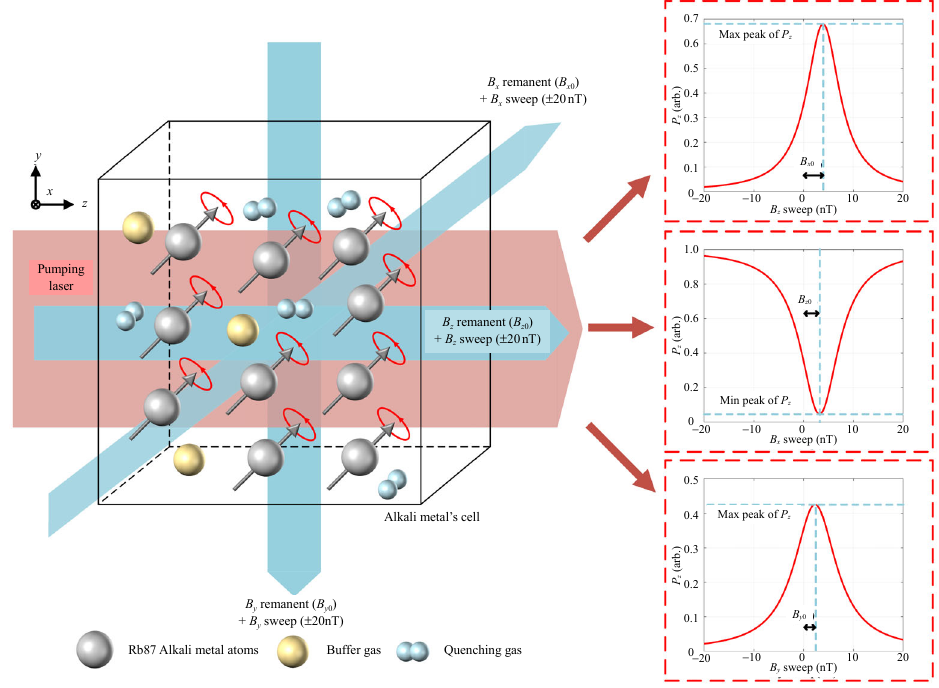
Fig. 1 Schematic of ZFR in the SEFR AM. In each of the three axes, a magnetic field sweeping ranging from − 20 nT to 20 nT is applied. The response in the x - and y -axes is a forward Lorentzian line pattern, and the response in the z -axis is a reverse Lorentzian line pattern. The residual magnetic field is the magnitude of the magnetic field corresponding to the extreme point of the response along the three